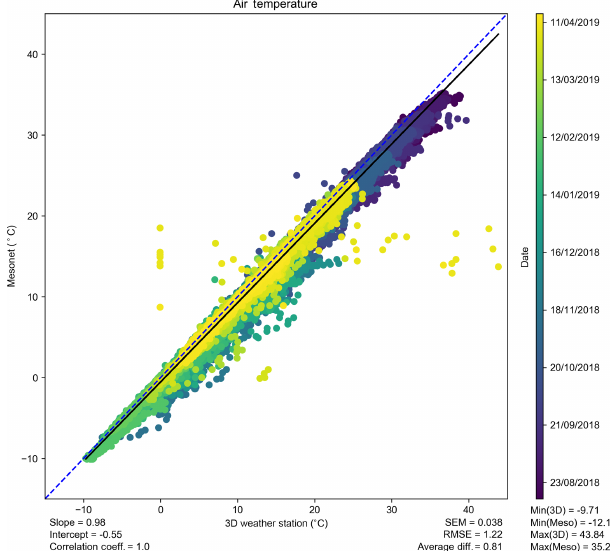
Figure 5. Comparison of the low-cost MCP9808 temperature sen- sor ( x ) and the Oklahoma Mesonet ( y ) for the entire deployment, color-coded by time. The one-to-one reference line (blue dashed) and linear regression line (black solid) are overlaid.